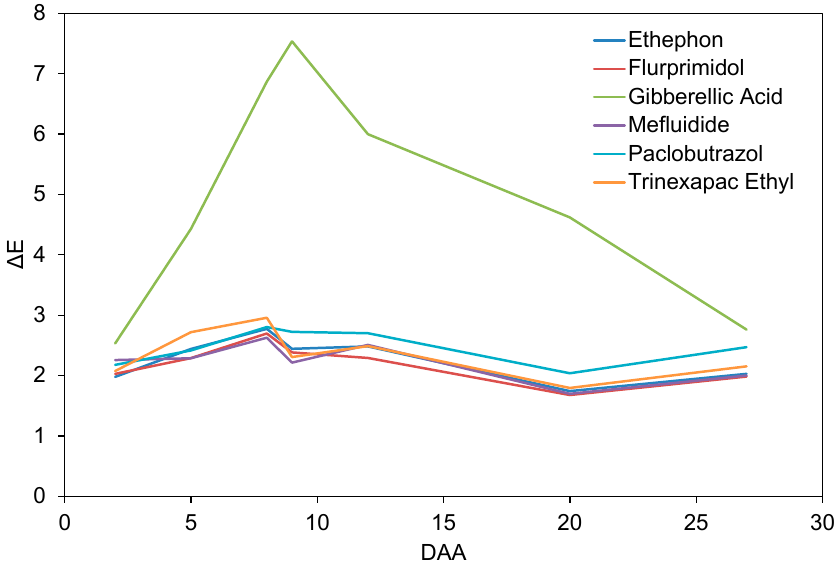
Figure 4. The total color difference ( ∆ E ) of Kentucky bluegrass after plant growth regulator application over time (in days after application, DAA).